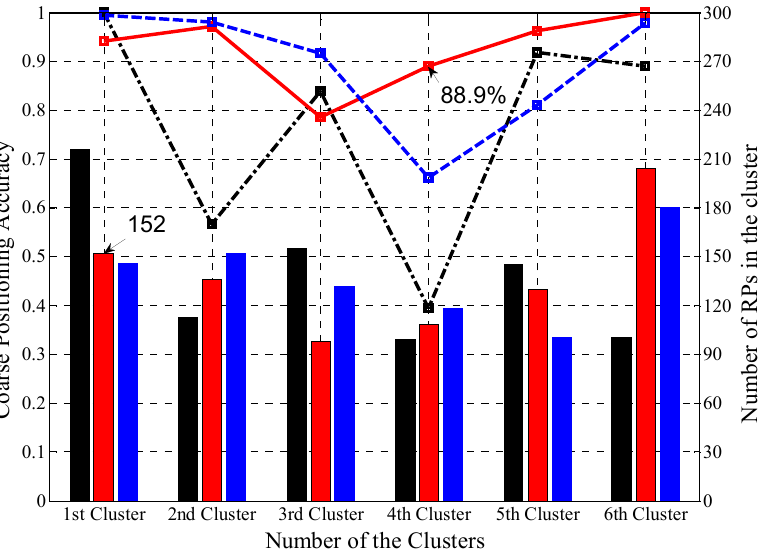
Figure 9. The different clustering results and the coarse positioning performances for the three